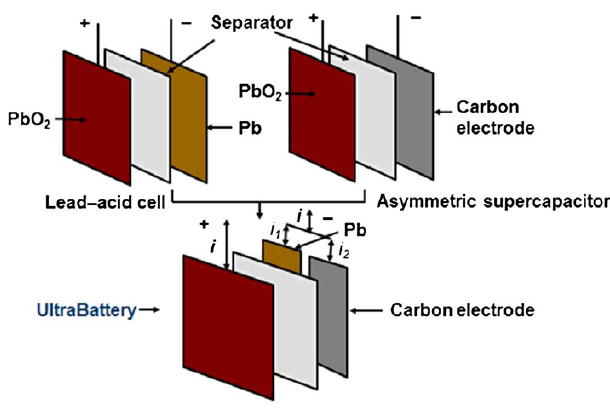
Figure 24. Structure of the UltraBattery technology